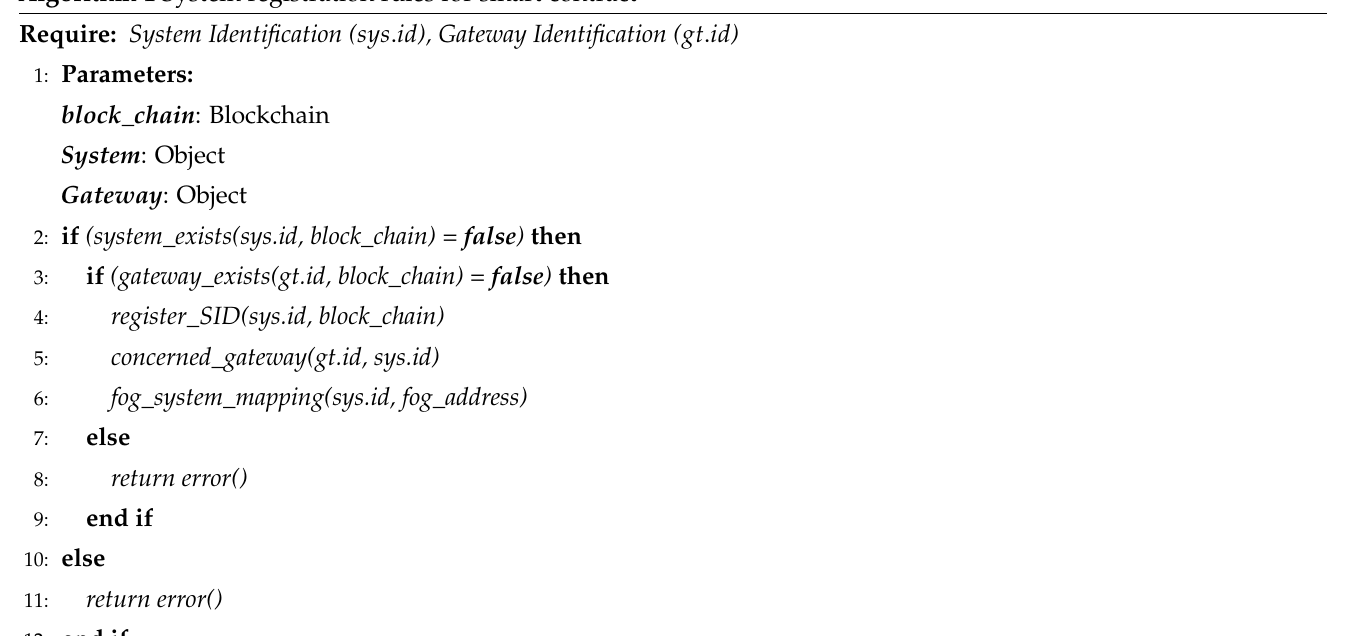
Algorithm 1 System registration rules for smart